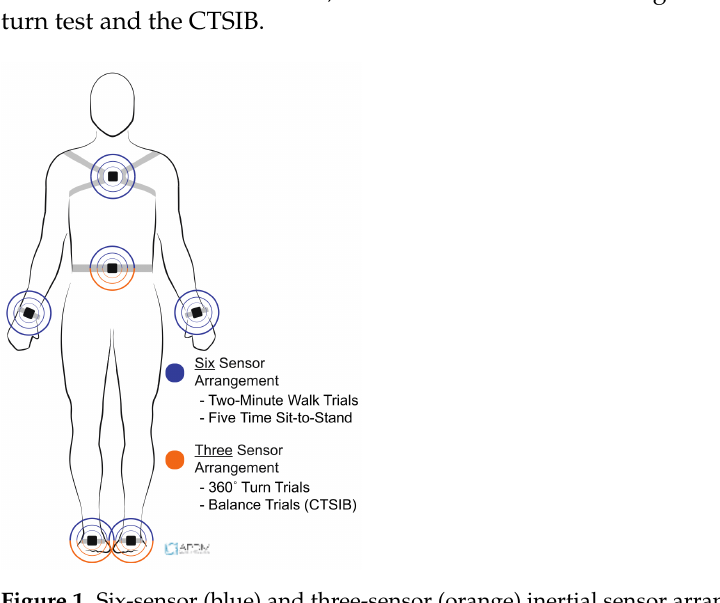
Figure 1. Six-sensor (blue) and three-sensor (orange) inertial sensor arrangement. Each wireless inertial sensor collects data at 128 Hz and houses an accelerometer, gy- roscope, magnetometer, and barometer. Following each trial, data was wirelessly streamed from the wireless sensors to a laptop computer, where mobility variables were automati- cally quantified through Mobility Lab software (V2, APDM, Inc., Portland, OR, USA). The magnitude of variability was either quantified in Mobility Lab (i.e., lateral step variability) or calculated from the Mobility Lab output as the coefficient of variation (CoV)